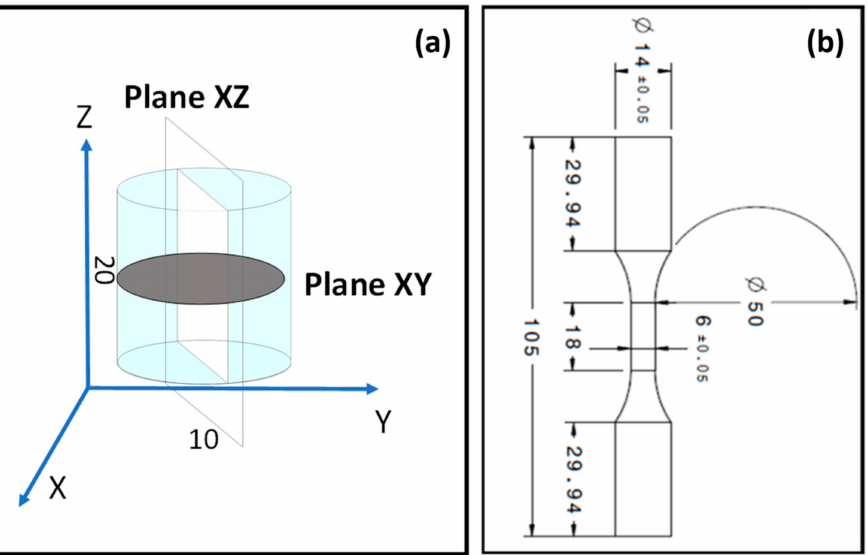
Figure 1. Geometry and dimensions corresponding to ( a ) specimens for microstructural analysis and ( b ) static tensile and fatigue specimens; all dimensions are in